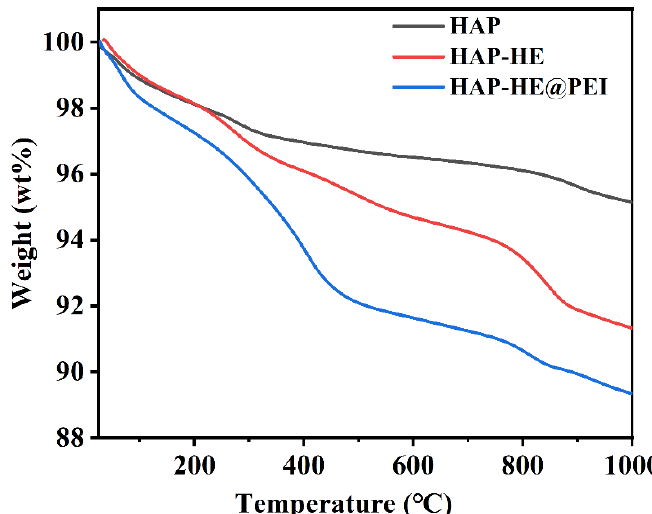
Figure 5. TGA curves of HAP, HAP − HE and HAP − HE@PEI.